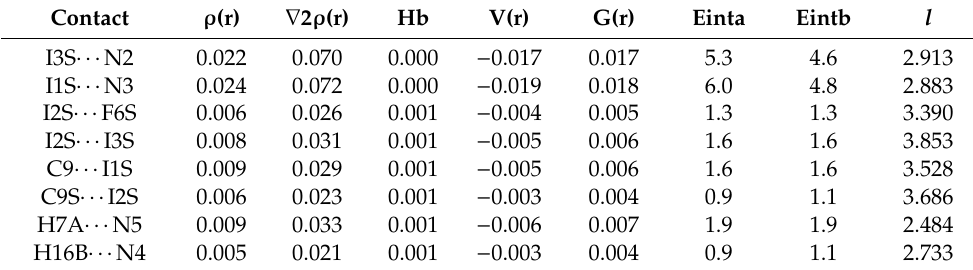
Table 4. Values of the density of all electrons— ρ ( r ), Laplacian of electron density— ∇ 2 ρ ( r ), energy density—H b , potential energy density—V( r ), and Lagrangian kinetic energy—G( r ) (a.u.) at the bond critical points (3, − 1), corresponding to different non-covalent interactions in ( ASZ ) 3 ·( 1,4-FIB ) 4 , bond lengths— l (Å), as well as energies for these contacts E int (kcal/mol), defined by two approaches.*